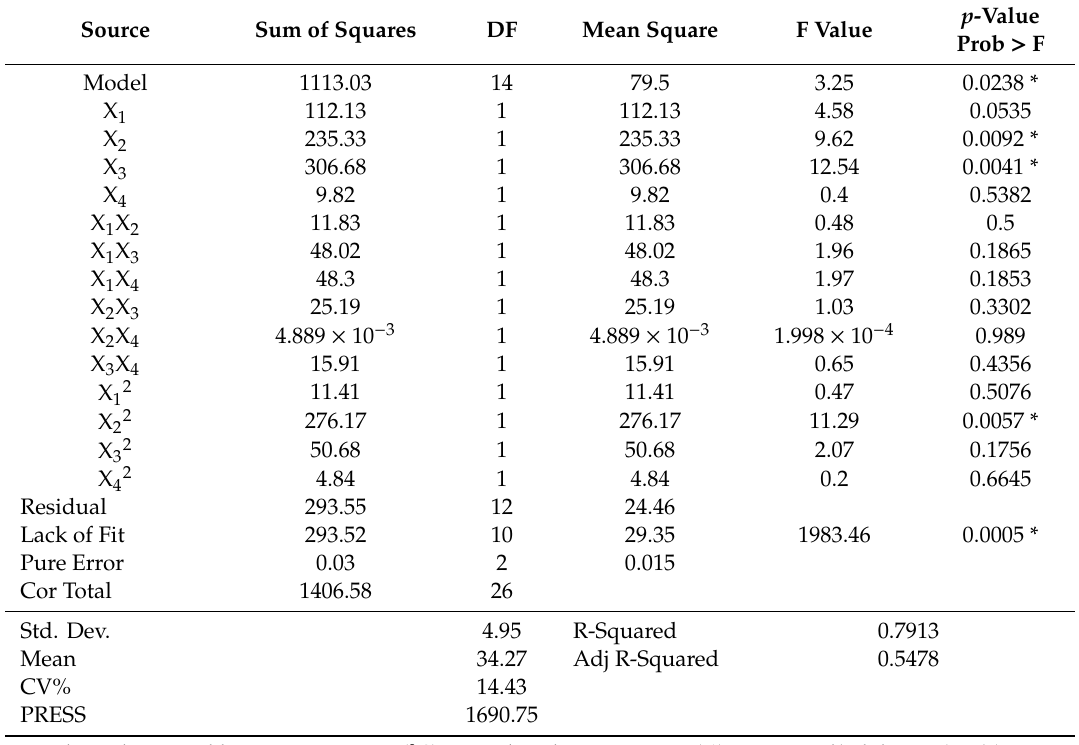
Table 3. ANOVA for the experimental results of central-composite rotatable design